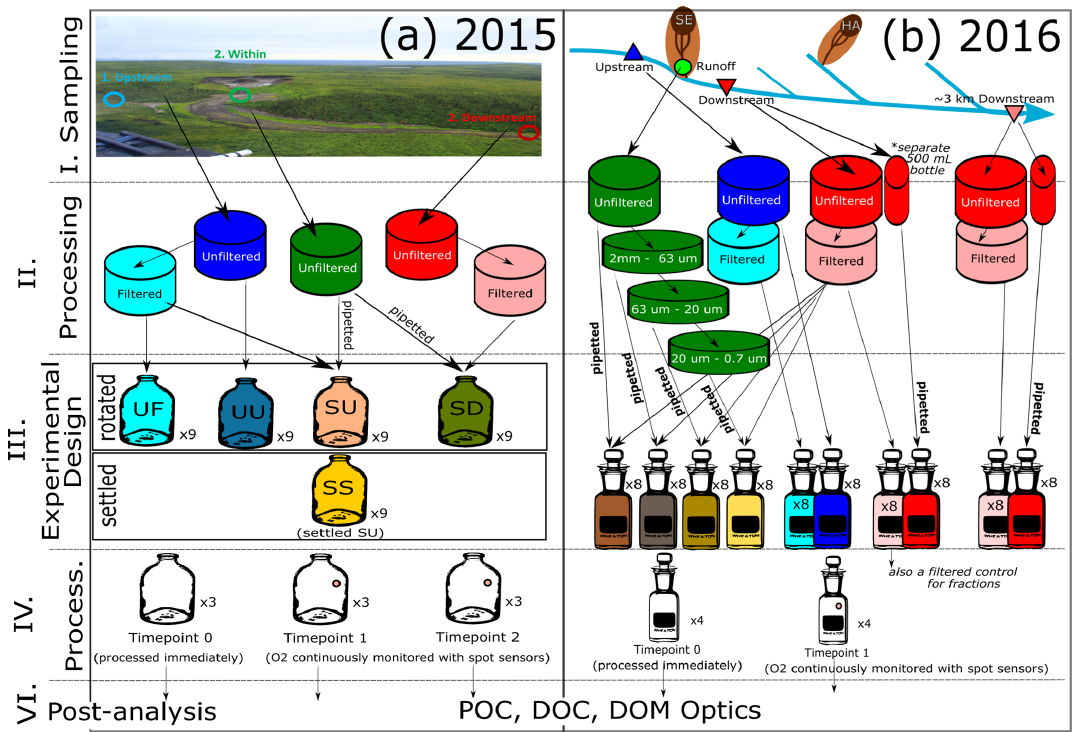
Figure 2. Flow chart for processing of (a) 2015 and (b) 2016 experiment. Note that time point two for 2015 occurred shortly after time point one due to rapid oxygen loss. Due to this, and the fact that some bottle replicates had to be removed because of anoxia, only data for time point one are presented in the main paper. Analyses show particulate (POC) and dissolved (DOC) organic carbon and dissolved organic matter (DOM) optics (SUVA 254 ). Flow chart for 2019 is provided in Appendix